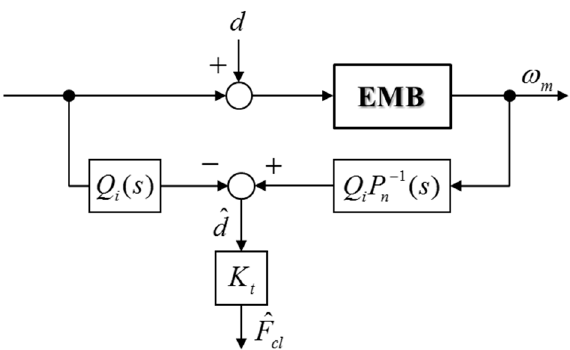
Figure 6. Structure of a CFO.